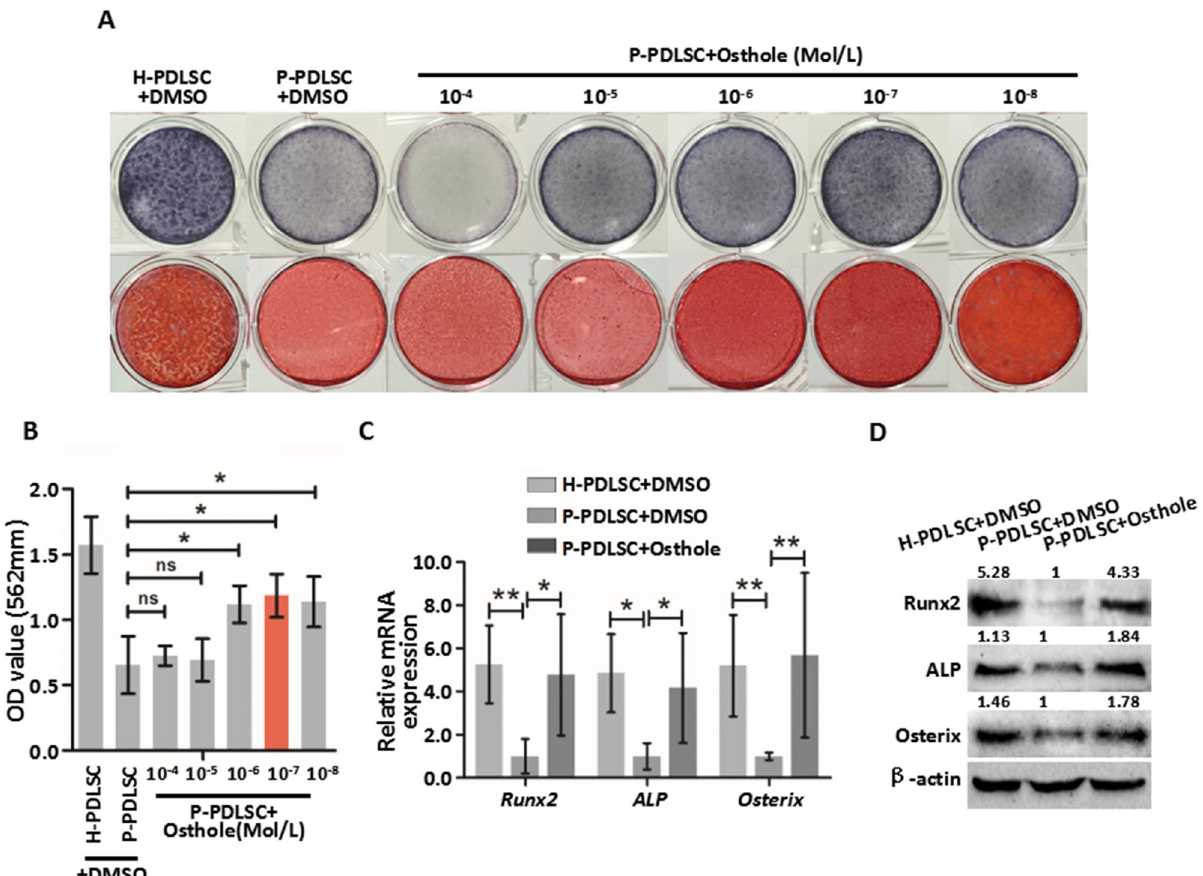
Figure 1. Osthole reverses defective osteogenic ability of P-PDLSCs. ( A ) ALP staining and ARS staining after 7 days (ALP staining) and 21 days (ARS staining) in H-PDLSCs and P-PDLSCs with different concentrations of Osthole (0 Mol/L, 10 −4 Mol/L, 10 −5 Mol/L, 10 −6 Mol/L, 10 −7 Mol/L and 10 −8 Mol/L). ( B ) Quantification of ARS staining for light absorbance at 562 nm. ( C ) Gene expression of Runx2, ALP and Osterix in H-PDLSCs, P-PDLSCs and P-PDLSCs with 10 −7 Mol/L Osthole as assayed by qRT-PCR. ( D ) Protein expression of Runx2, ALP and Osterix in H-PDLSCs, P-PDLSCs and P-PDLSCs with 10 −7 Mol/L Osthole as assayed by Western blot. * P < 0.05, ** P < 0.01, ns: P ≧ 0.05, n =